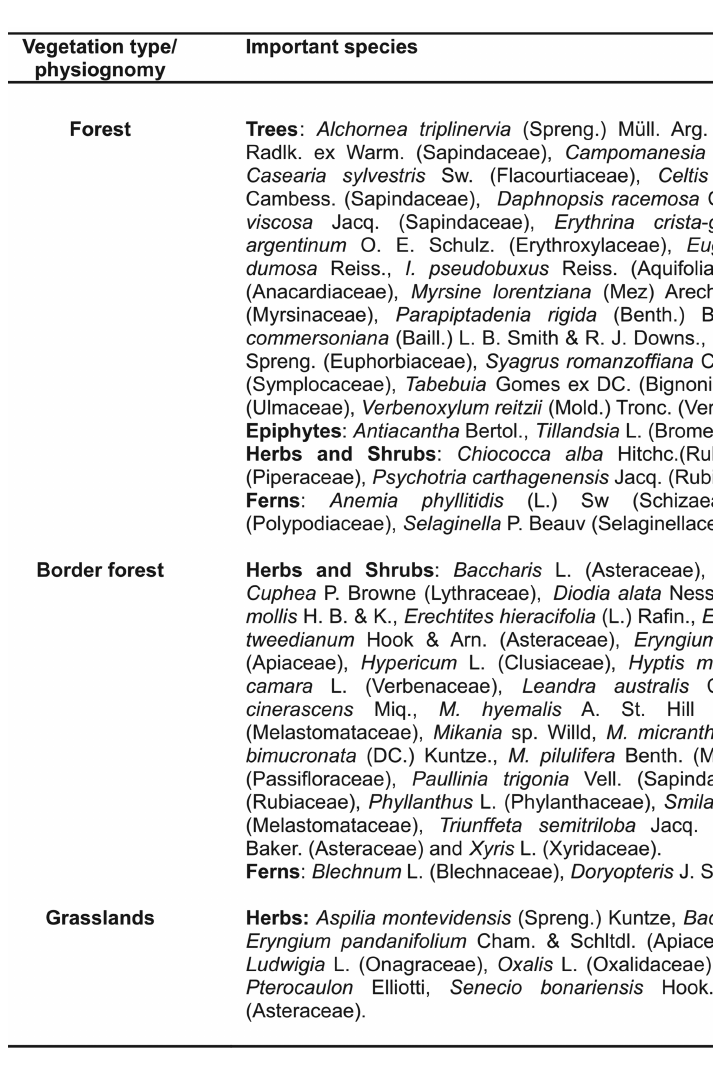
Fig. 5 – Extant species of the forest and grasslands in Santo Antônio da Patrulha, RS,